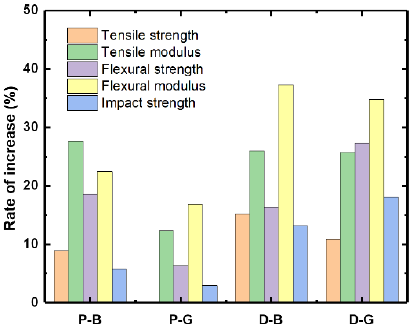
Figure 9. Increase rate of the mechanical properties of the GF/PA6 specimen (when increasing fiber content from 40 wt% to 50 wt%).